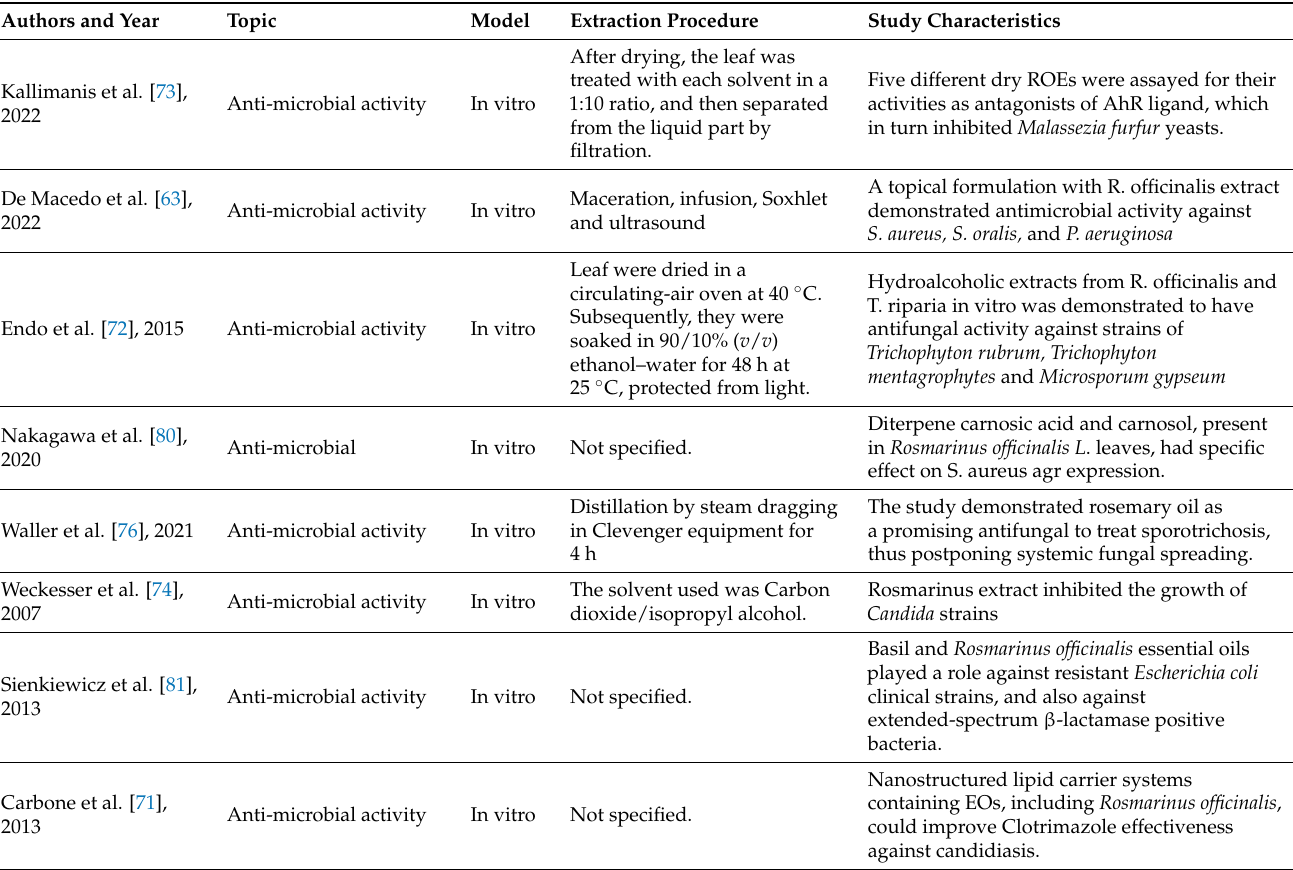
Table 2. The antimicrobial activity of R.